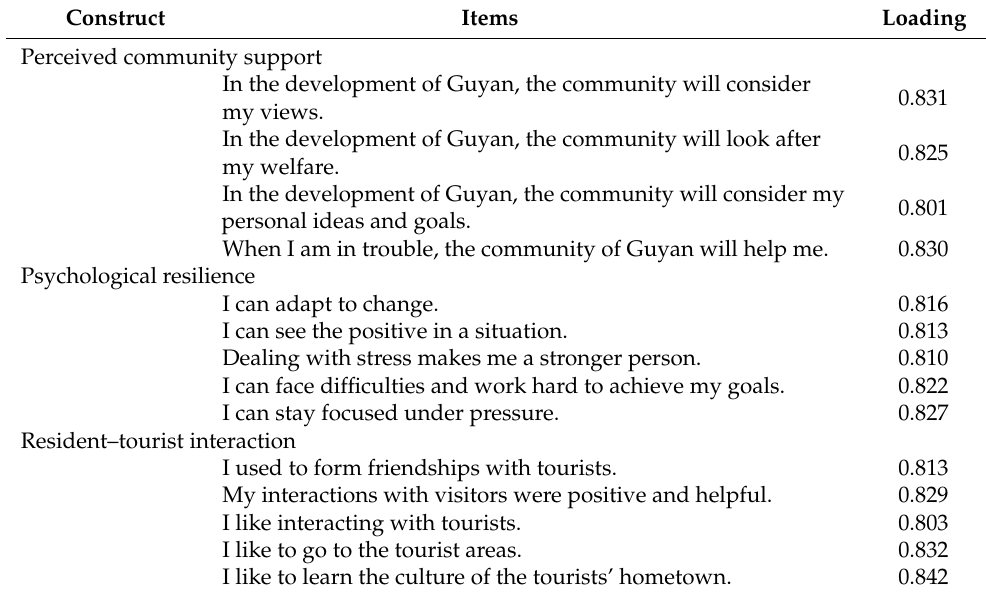
Table 3. Assessment of the measurement